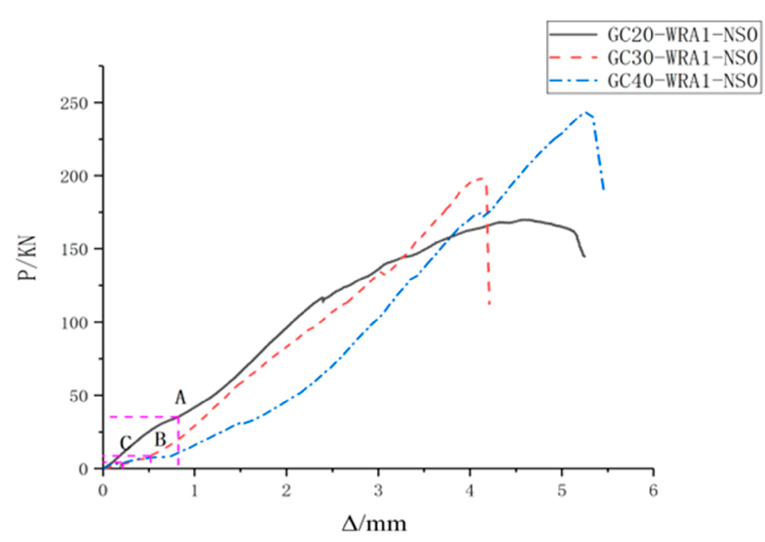
Figure 11. Curves of specimens at different concrete grades.